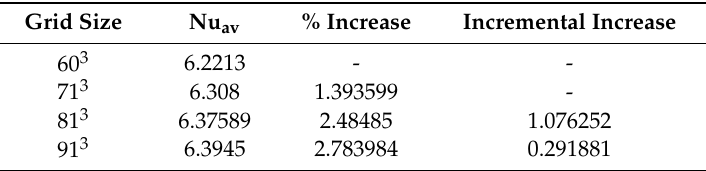
Table 2. Grid independency test: Ra = 10 5 , α = 90 ◦ , Ha = 50 and ϕ = 0.05.